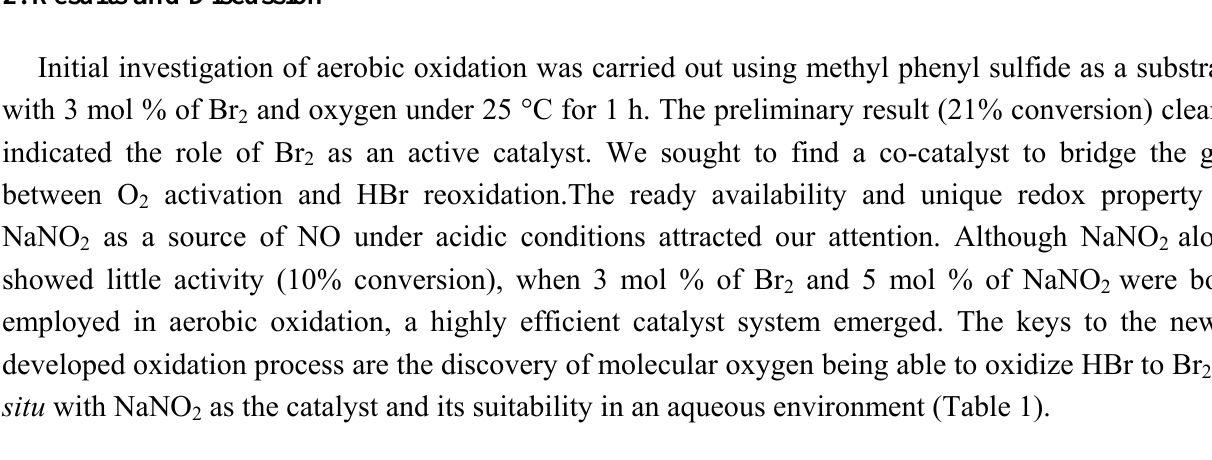
Table 1. The catalysts effect on the reaction. a